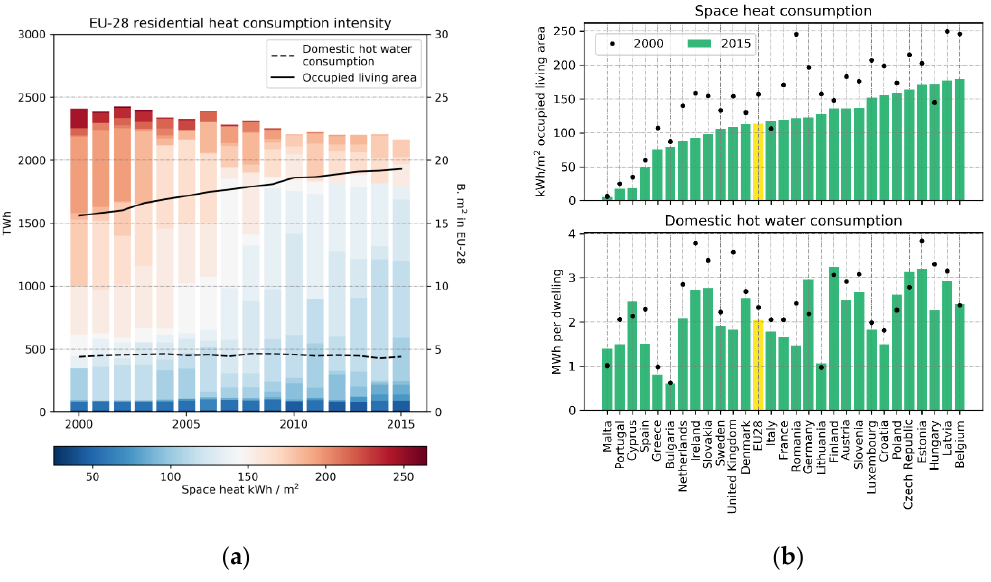
Figure 7. ( a ) Development of EU-28 total residential heat consumption from 2000 to 2015 (left y-axis), split into MS average heat consumption intensity per m 2 , and development of occupied residential living area (right y-axis). ( b ) Residential space heat consumption per occupied living area and domestic hot water consumption per dwelling for each MS in 2015 with a reference value for year 2000. MSs are sorted based on space heat consumption per occupied living area in 2015.